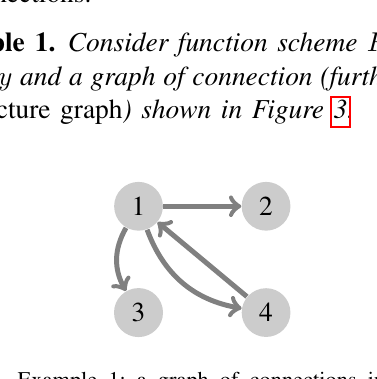
Example 1: a graph of connections in a regular Boolean